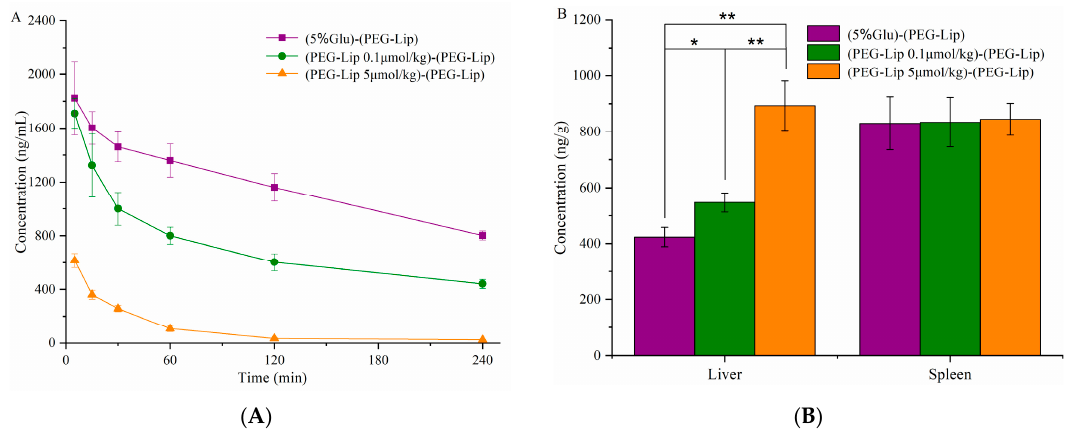
Figure 3. ( A ) Pharmacokinetic profile in wistar rats after the repeated injection of PEG-Lip (0–4 h). ( B ) Hepatic and splenic accumulation (4 h) in rats after second injection of PEG-Lip. Data were shown as mean ± S.D., n = 3. * p < 0.05, ** p < 0.01.